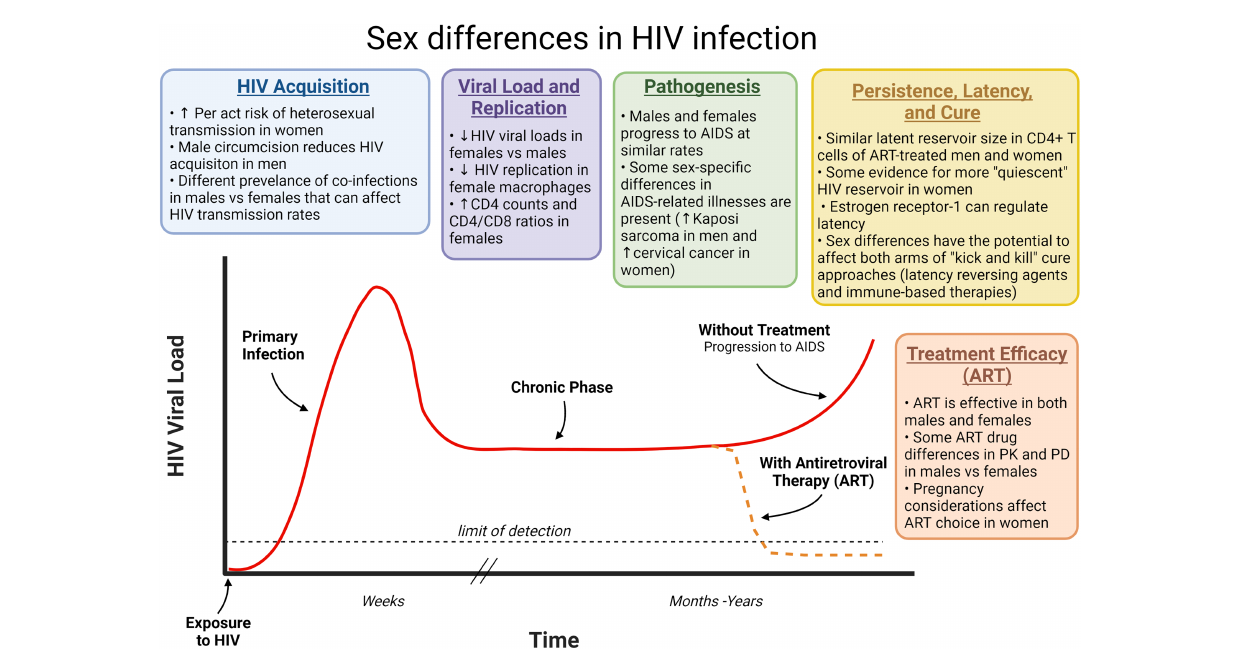
FIGURE 1 | How sex differences can affect different phases of HIV infection. HIV infection progresses from primary infection through a chronic phase that often lasts years before development of AIDS approximately 10 years after HIV acquisition. ART prevents this disease progression by inhibiting virus replication and reducing viral loads. Sex differences can affect each phase of this infection as indicated. ART, Antiretroviral therapy; HIV, human immunode fi ciency virus; AIDS, acquired immunode fi ciency syndrome; PK, pharmacokinetics; PD,